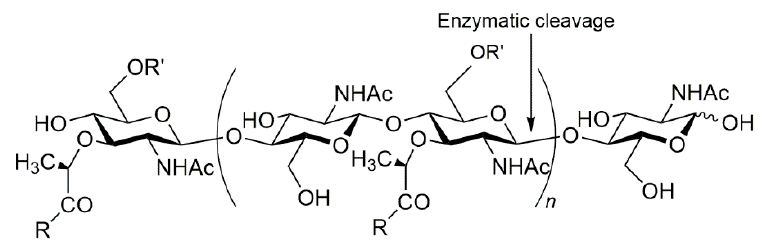
Figure 1. The cleavage site of the cell wall glycan by lysozyme/muramidase.